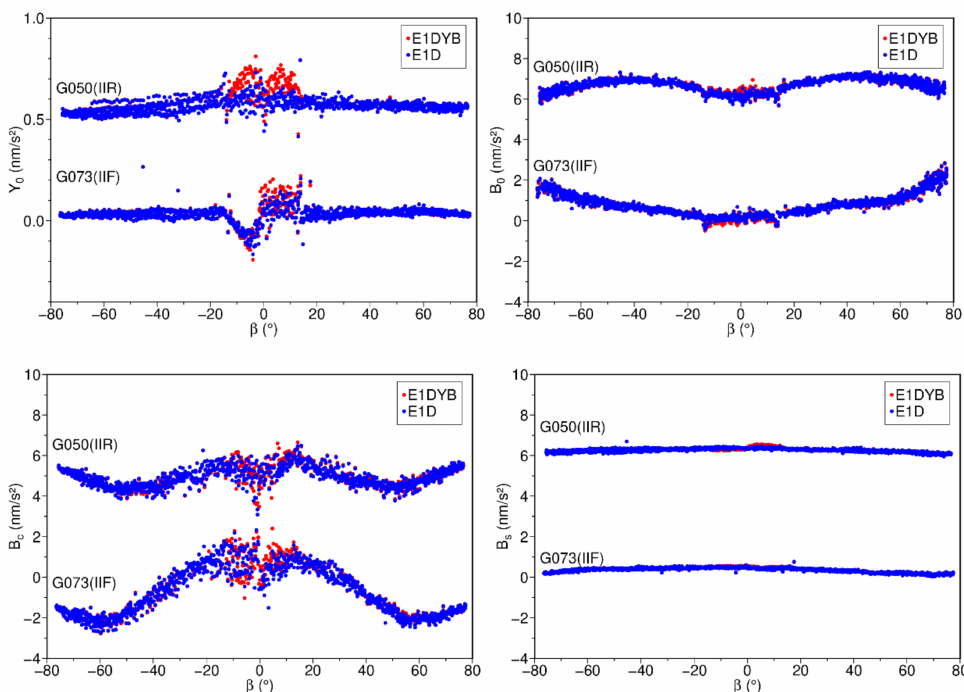
Figure 5. SRP coefficients Y 0 ( upper left ), B 0 ( upper right ), B C ( lower left ), and B S ( lower right ) with respect to the β angle in solution E1DYB ( red dots ) and solution E1D ( blue dots ) spanning from 2017 to 2019. The results of SVN G050 are all shifted by 6 nm/s 2 for better visualization, except for the coefficient Y 0 . Note the different y -axis scales between the upper-left panel (the Y 0 panel) and the